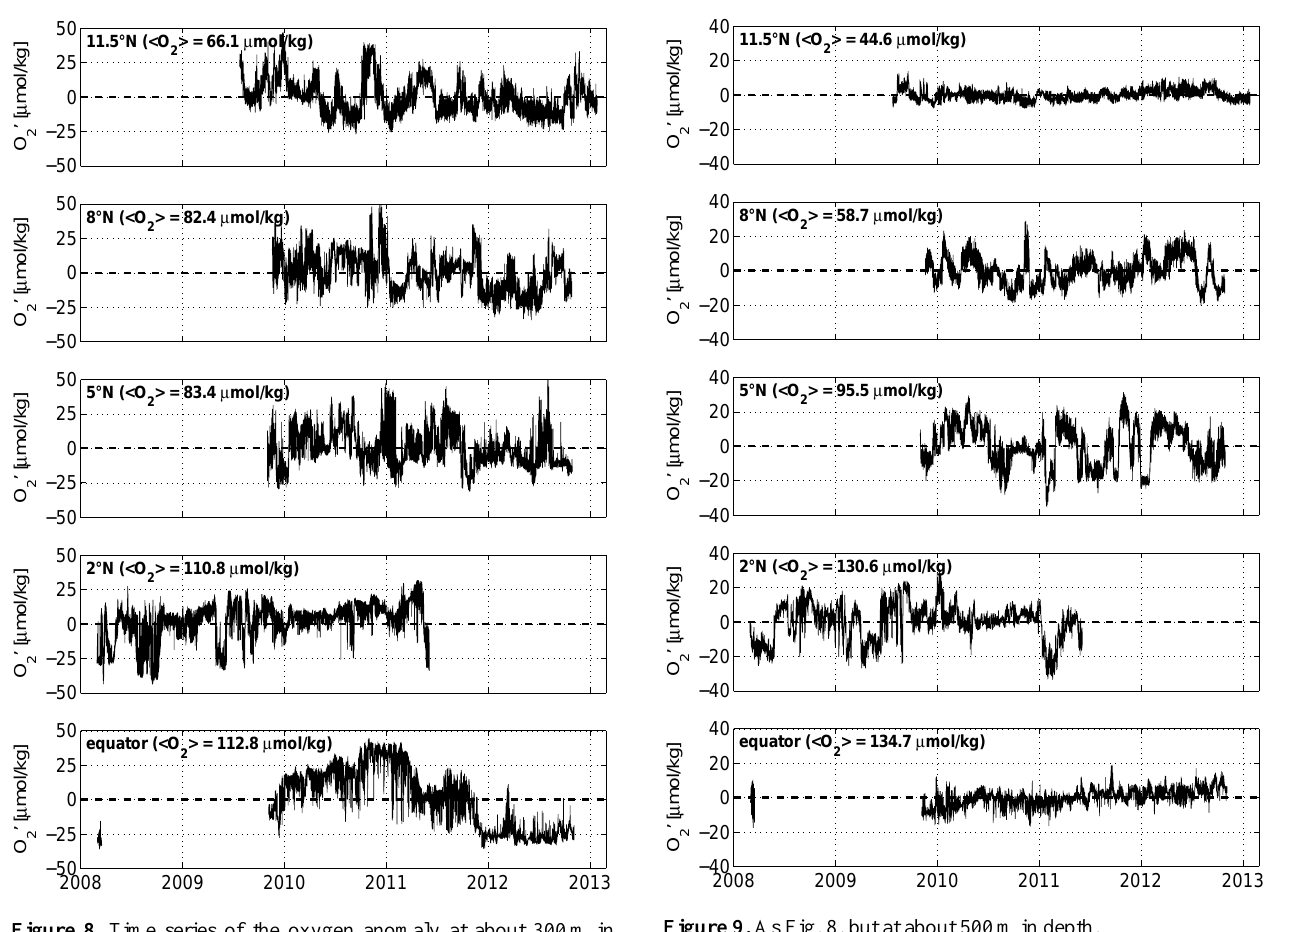
Figure 8. Time series of the oxygen anomaly at about 300m in depth from moored observations along 23 ◦ W at different latitudes. Mean oxygen values at the different mooring locations are given in brackets.